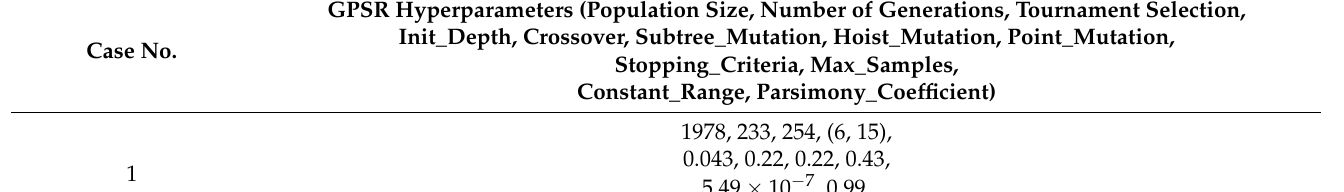
Table 4. The combination of the GPSR hyperparameter values for which the highest estimation accuracy was achieved.